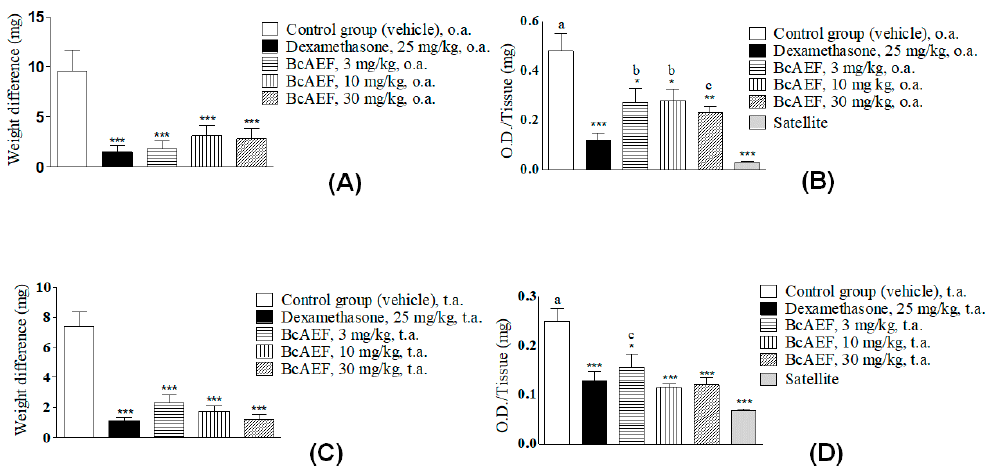
Figure 6. Anti-inflammatory e ff ect of BcAEF evaluated on croton oil-induced ear edema. ( A , C ) Results are expressed as the mean ± standard error media; weight di ff erence (mg) = weight di ff erences of equal portions obtained from the treated and untreated ears of the animals from each experimental group. ( B , D ) Tissue sample evaluated: ear fragment after exposure to croton oil; myeloperoxidase activity expressed as O.D. (optical density) per ear milligram. Groups: negative control (vehicle = acetone 70% to group with application topic or 10 mL kg − 1 of the PBS pH 7 + tween 80 5% to group with oral treatment), positive control (dexamethasone), and experimental group (BcAEF: alkaloid enriched fraction extracted from the aerial parts of Boehmeria caudata Sw ). Legend: t.a. topic application; o.a.